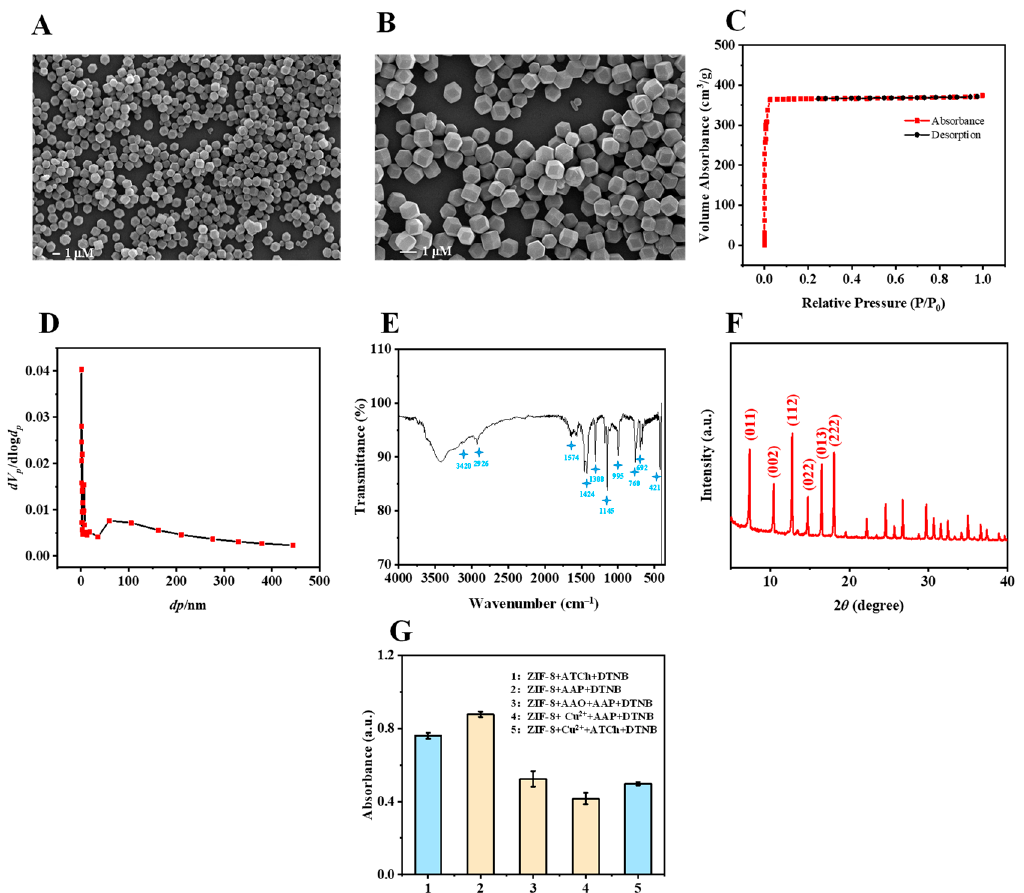
Figure 2. SEM images ( A , B ), nitrogen adsorption-desorption isotherm ( C ), pore-size distribution ( D ), FT-IR spectrum ( E ), and X-ray diffraction pattern ( F ) of ZIF-8. The UV absorption (405 nm) of ( G -1) ZIF-8 + ATCh + DTNB, ( G -2) ZIF-8 + AAP + DTNB, ( G -3) ZIF-8 + AAO + AAP +DTNB, ( G -4) ZIF-8 + Cu 2+ + AAP + DTNB, ( G -5) ZIF-8 + Cu 2+ + ATCh + DTNB. Buffer pH, 7.5 for G (1 and 5), 8.0 for G (2, 3, and 4); ZIF-8, 4 mg for G; DTNB, 13.3 mM for G (1 and 5), 1.1 mM for G (2, 3, and 4); incubation temperature, 60 °C for G; ATCh, 11.3 mM for G (1 and 5); AAP, 7.3 mM for G (2, 3, and 4); reaction time, 12 min for G (2, 3, and 4), 15 min for G (1 and 5); centrifugation time, 1 min for G (1 and 5), 3 min for G (2, 3, and 4); AAO, 454.5 U/L for G (3); Cu 2+ , 4.5 µM for G (4), 20.8 µM for G (5).